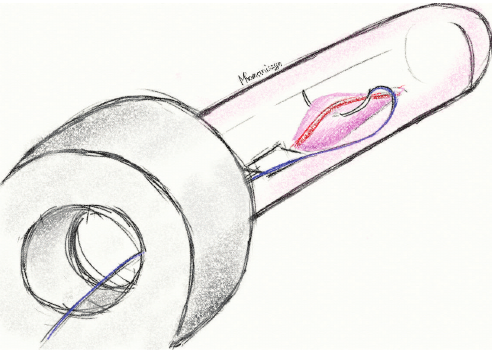
Figure 2: A stitch ligating a haemorrhoidal artery.